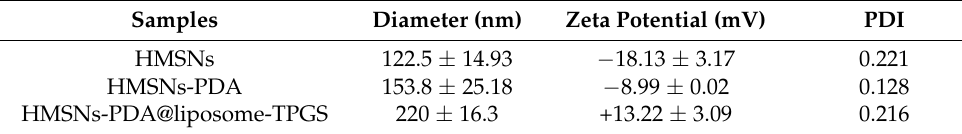
Figure 1. TEM images of HMSNs ( A ), HMSNs-PDA ( B ), and HMSNs-PDA@liposome-TPGS ( C ). Enlarged TEM image of HMSNs-PDA@liposome-TPGS ( D ). Table 1. Diameter (nm), zeta potential (mV), and PDI values of